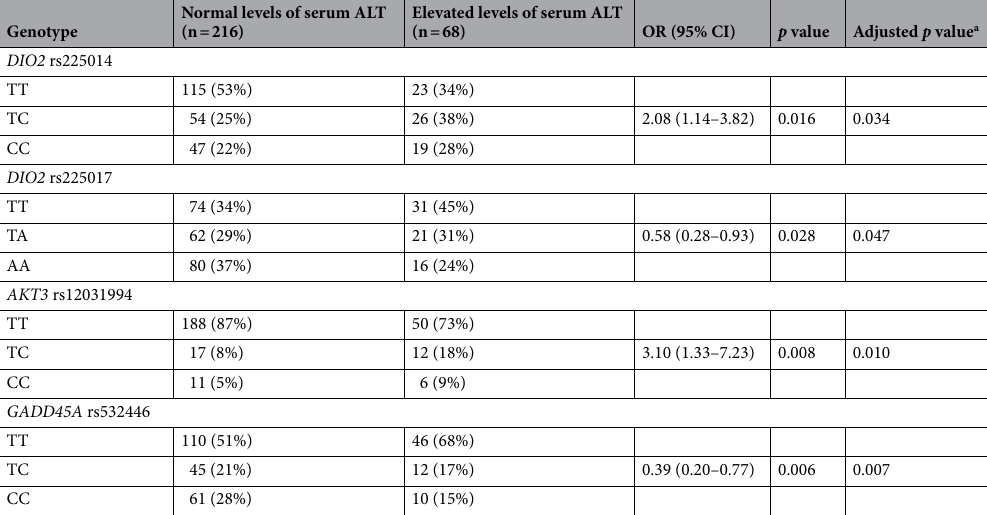
Table 3. Results of logistic regression analyses for elevated ALT risk in chronic hepatitis B patients. CI confidence interval, OR odds ratio, a p -value adjusted for age and sex.